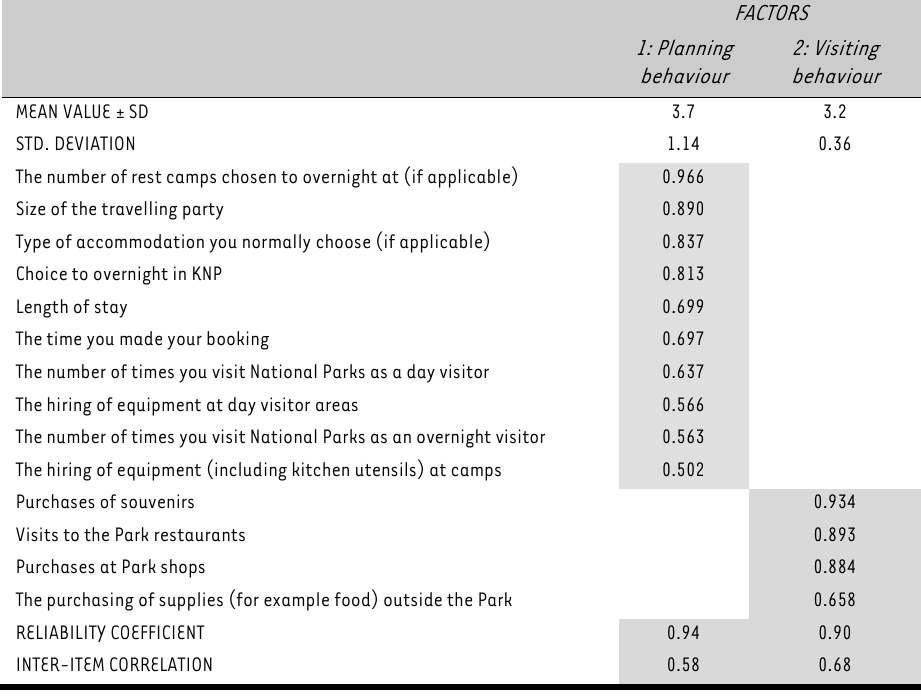
Factor analysis results of visitors’ behaviour in relation to the